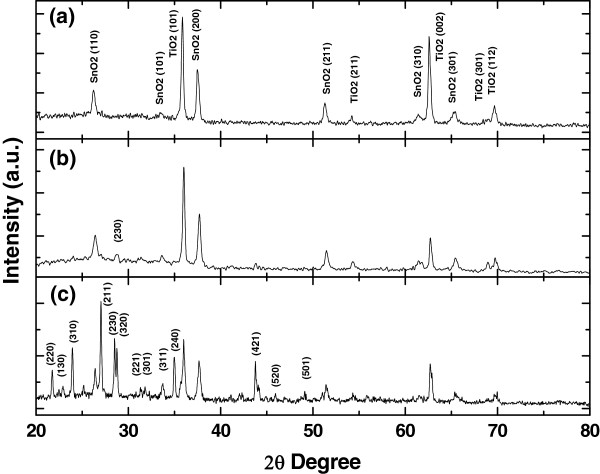
XRD patterns. The bare TiO2 nanorod arrays (a), the as-grown Sb2S3-TiO2 nanostructure electrode (b), and the annealed Sb2S3-TiO2 nanostructure electrode under 300°C (c).